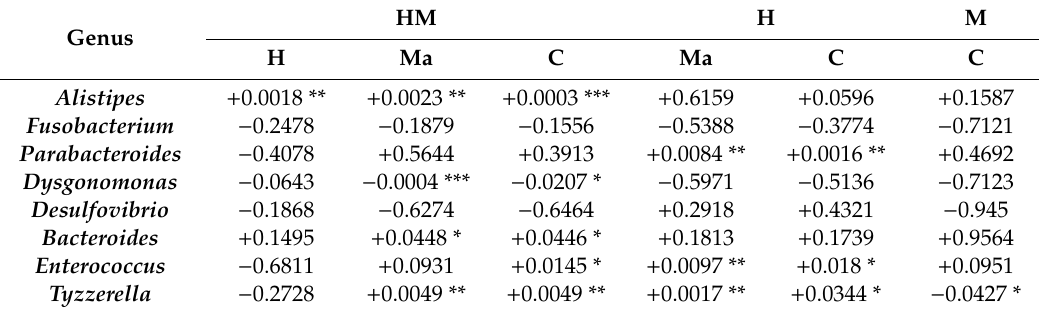
Table 4. p -Values for relative abundance comparison between di ff erent treatments.